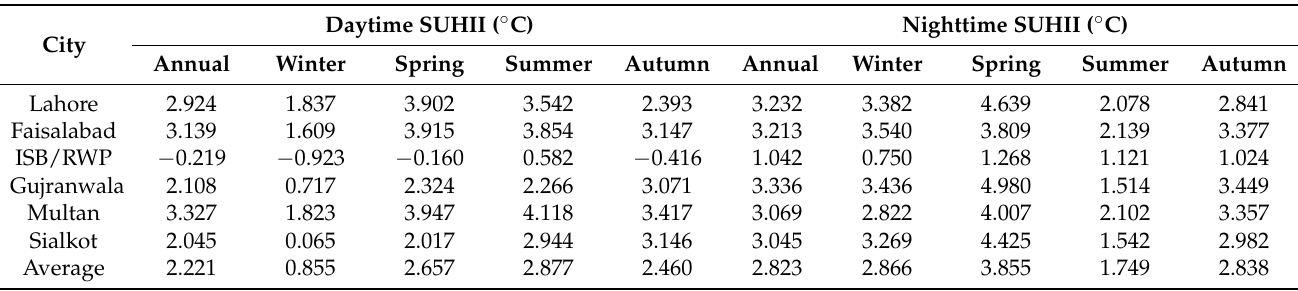
Table 2. Averaged annual and seasonal SUHII for each city from 2006 to 2020.